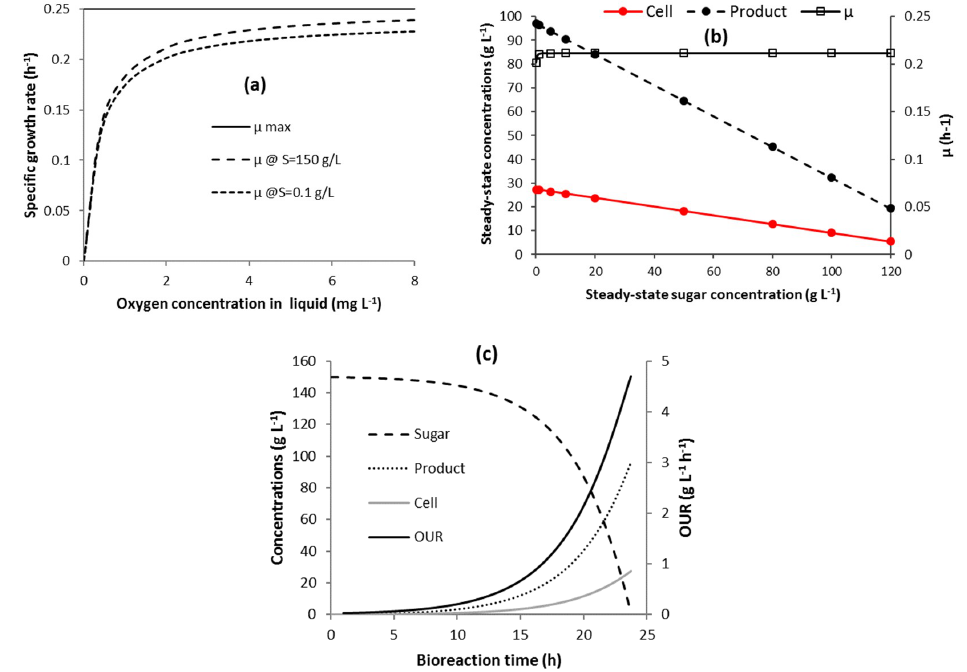
Figure 1. Bioreaction kinetics ( a ) effect of oxygen and sugar concentrations on specific growth rate, ( b ) effect of CSTB steady-state sugar concentration on product concentration and cell growth. ( C OL = 2 mg·L −1 ) and ( c ) batch bioreaction kinetics ( C OL = 2 mg·L −1 ).